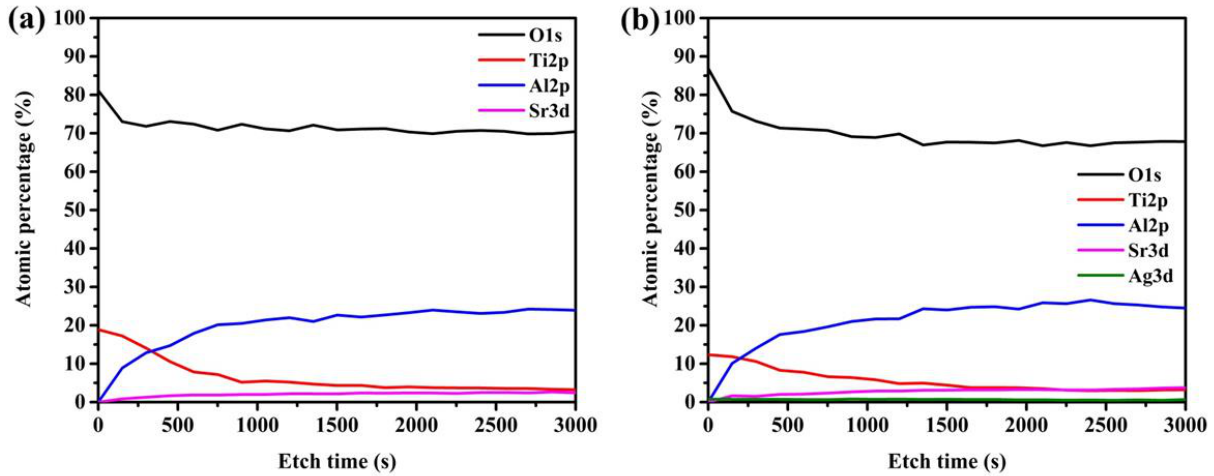
Figure 3. XPS depth profile spectra of ( a ) TiO 2 /Sr 4 Al 14 O 25 :Eu 2+ ,Dy 3+ and ( b ) Ag-TiO 2 /Sr 4 Al 14 O 25 :Eu 2+ ,Dy 3+ photocata- lyst/phosphor beads.